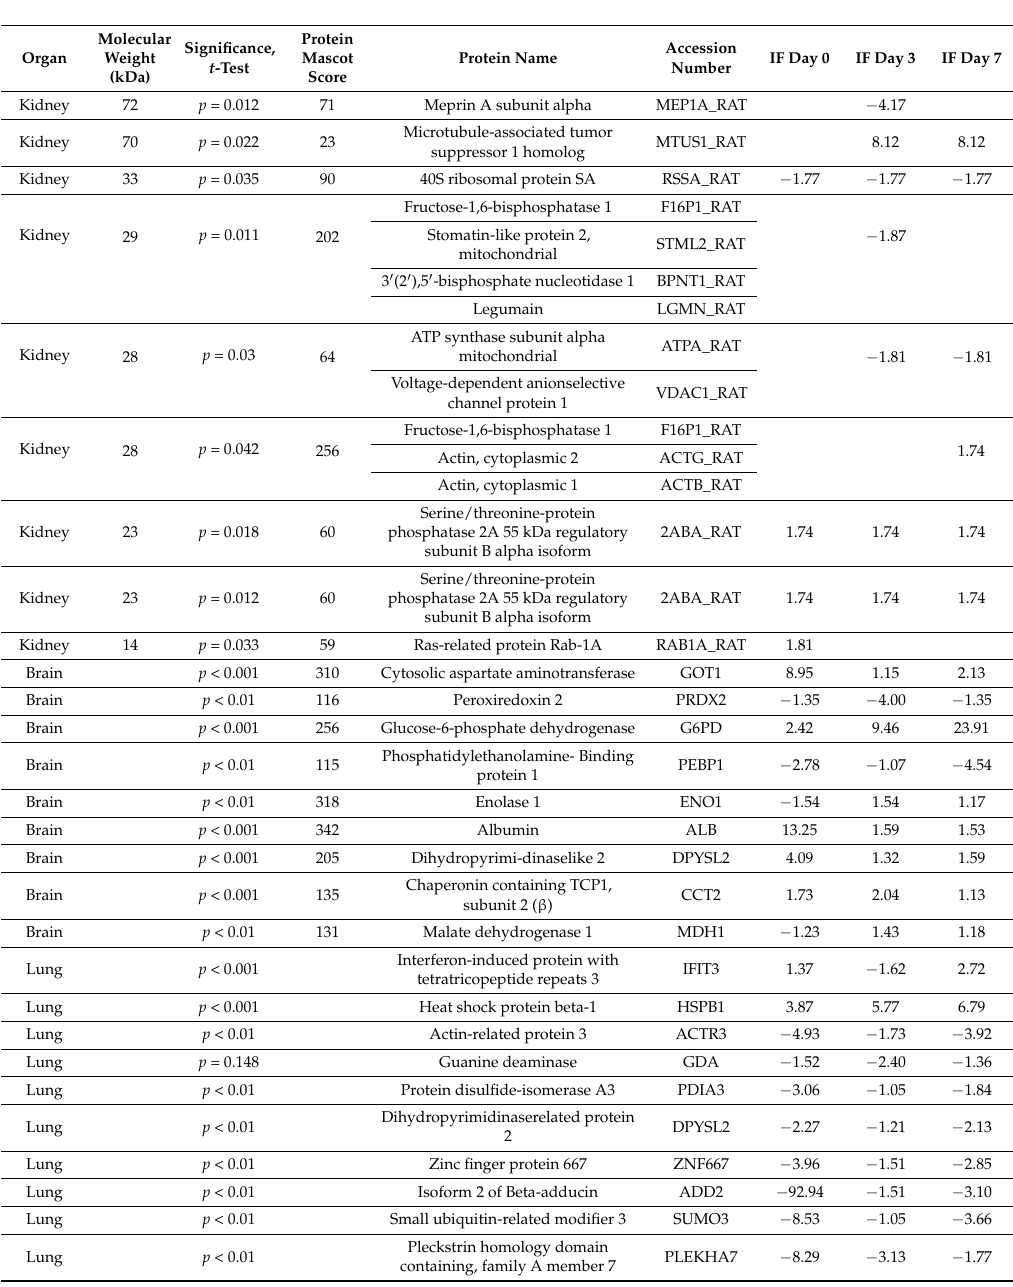
Table 2. Significantly regulated proteins in different tissues (brain, lung, and kidney). Significant induction factors (IF) are printed red. Up-regulation is expressed by a positive number and down-regulation by a negative